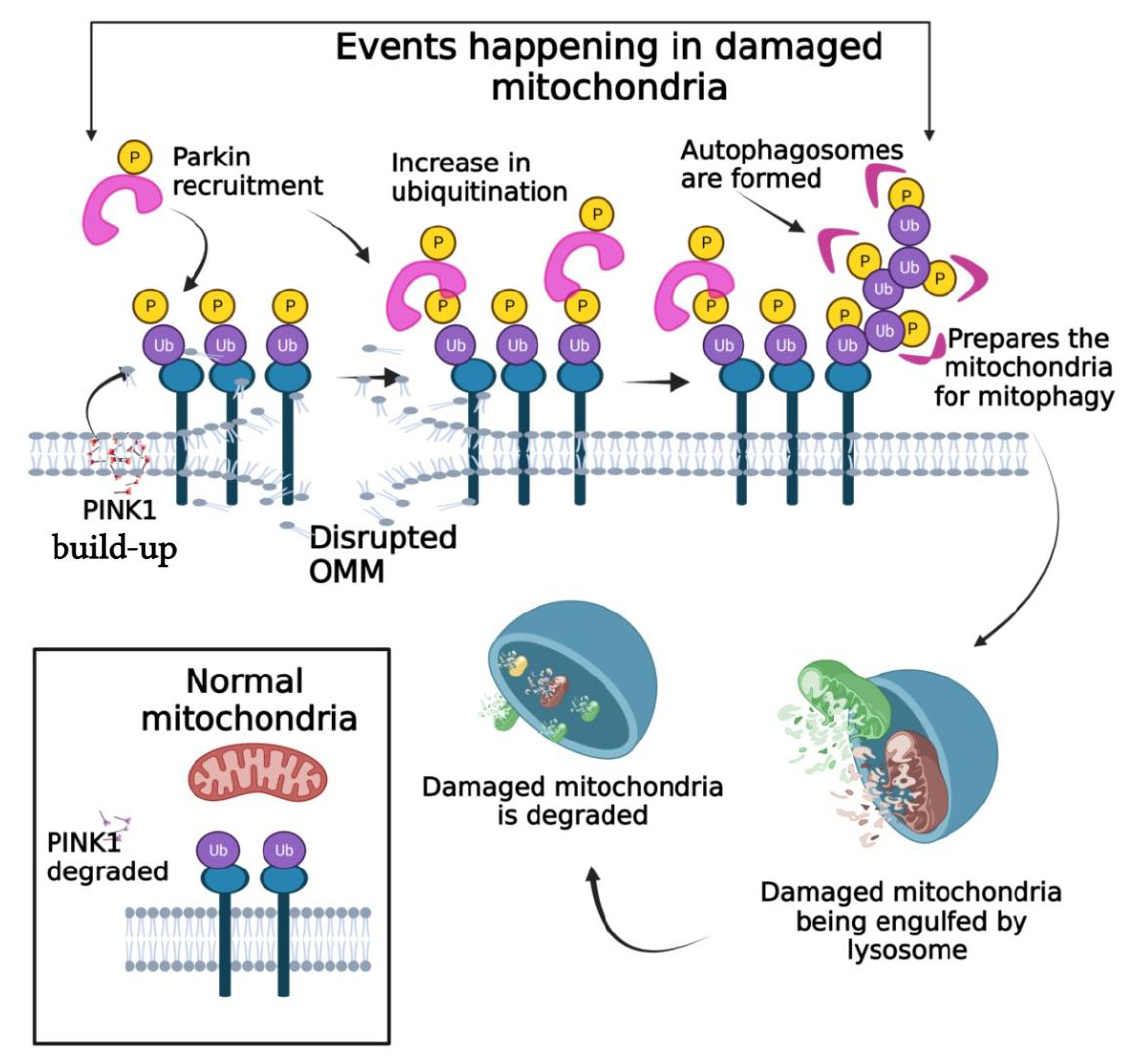
Figure 1. The process of mitophagy. When the outer mitochondrial membrane is disrupted, PINK1 is accumulated which in turn helps in the recruitment of Parkin and other receptor proteins. Au- tophagosomes formed prepare the mitochondria for mitophagy where the damaged or dysfunctional mitochondria are engulfed by lysosomes and degraded.